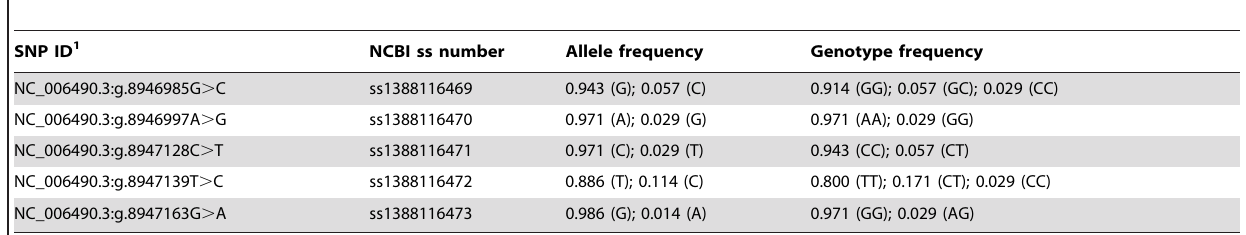
Table 1. Position and frequency of alleles and genotypes of SNPs identified in chimpanzee OXTR rs53576 surrounding region for a total of 35 unrelated